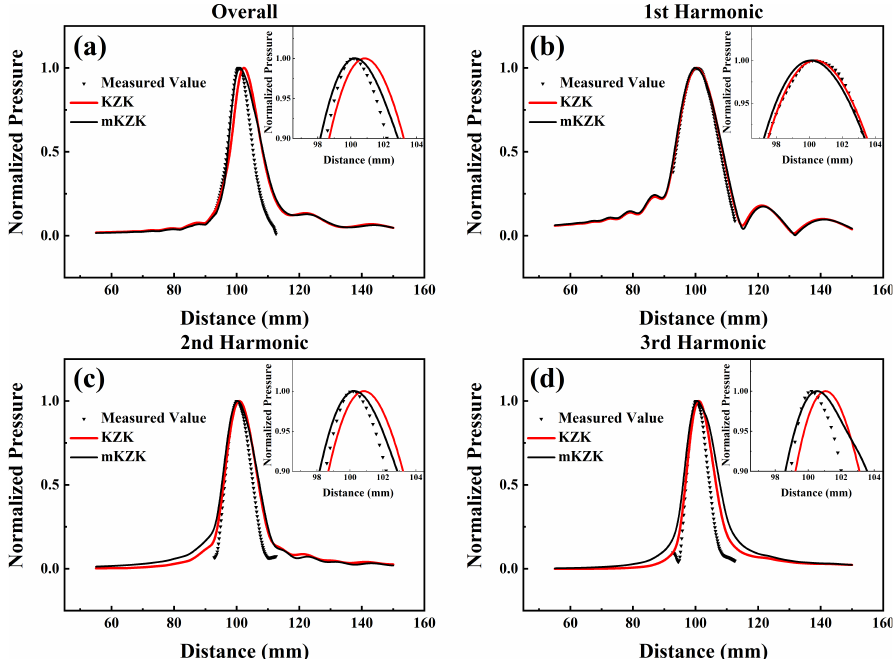
Figure 4. The normalized acoustic pressure distributions along the axis of the HIFU transducer, with the phantom placed at 37.7 mm away from the transducer. ( a ) the overall pressure; ( b ) the fundamental component; ( c ) the second harmonic; ( d ) the third